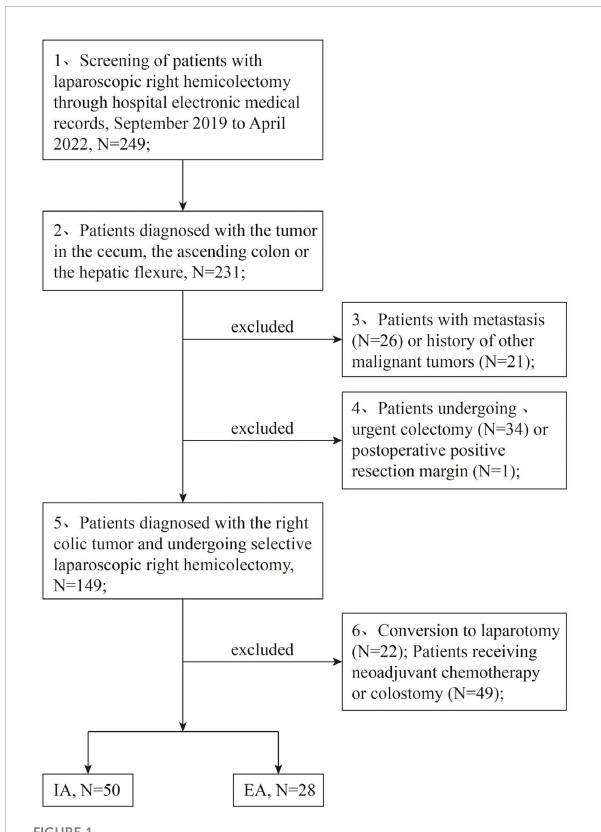
FIGURE 1 Flowchart of IA and EA Patient Selection in laparoscopic right hemicolectomy. IA, intracorporeal anastomosis; EA, extracorporeal